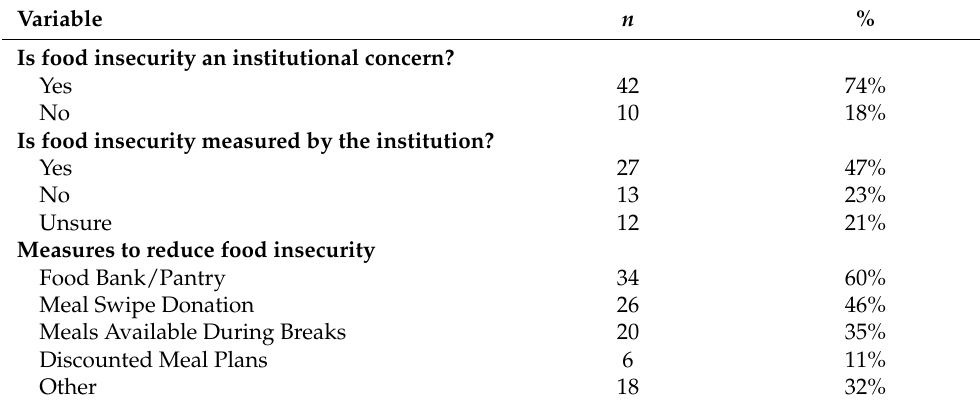
Table 3. Food insecurity concern and measurement among sampled institutions ( n =